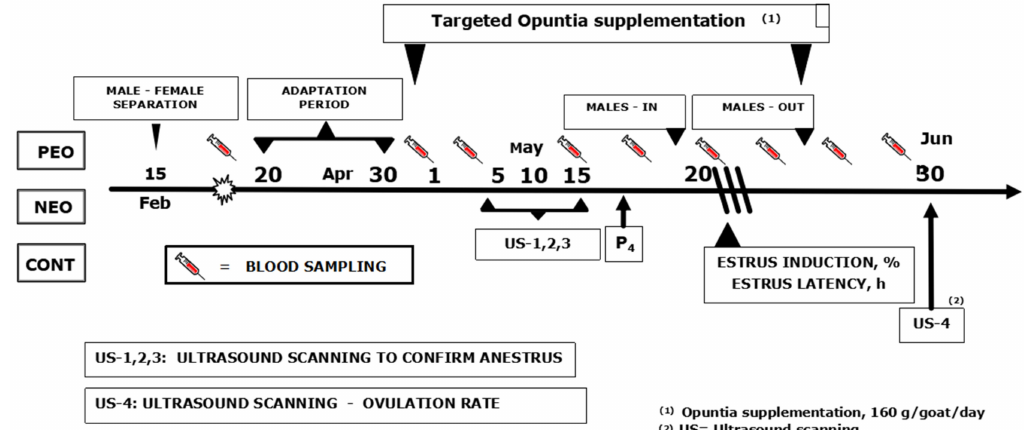
Figure 1. A schematic representation of the experimental protocol of targeted supplementation with Opuntia megacantha Salm-Dyck cladodes either protein-enriched (PEO) or non-protein enriched (NEO) as well as not supplemented control (CC) to adult mix-breed ( n = 45; Alpine-Saanen-Nubian × Criollo) female goats exposed to testosterone treated bucks and to an increased natural photoperiod (Apr–Jun; anestrous season) under semiarid-subtropical rangeland conditions in Northern Mexico (25 ◦ N). Note: More details were previously described in the main body of the